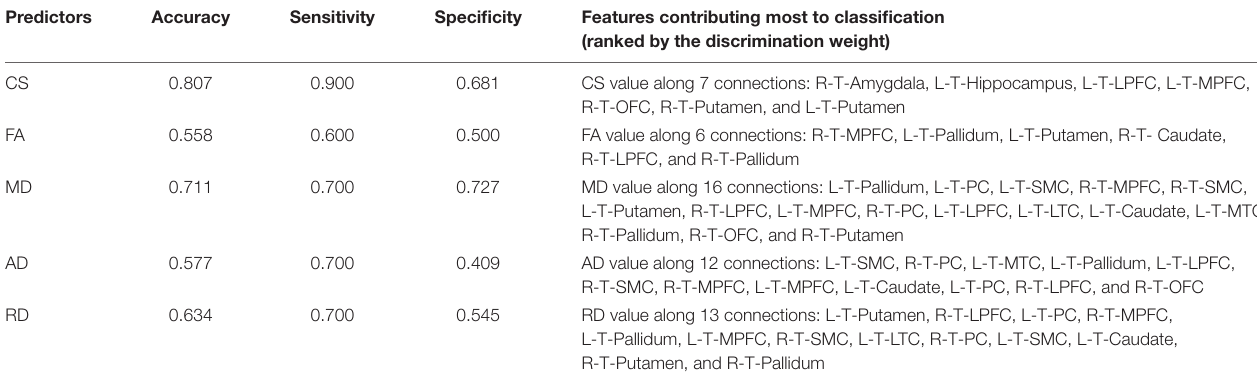
TABLE 3 | The performance of classification analysis between the cirrhotic patients with and without MHE.